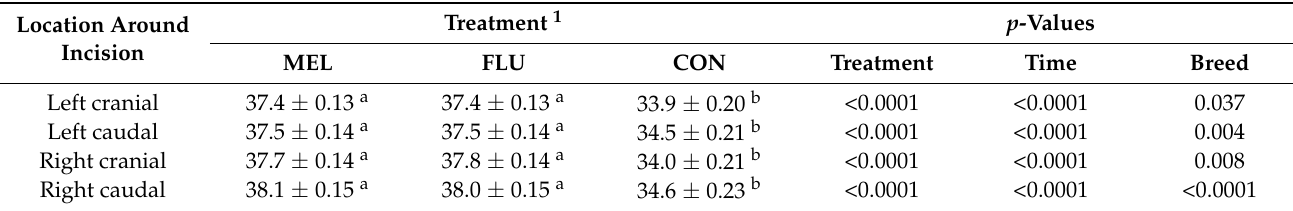
Table 3. Mean infrared thermography temperature ( ◦ C ± SEM) at the four test sites around the abdominal incision for each treatment group ( n = 12 sheep per analgesia group; n = 6 controls). For controls, these sites were estimated based on where the incision would have been